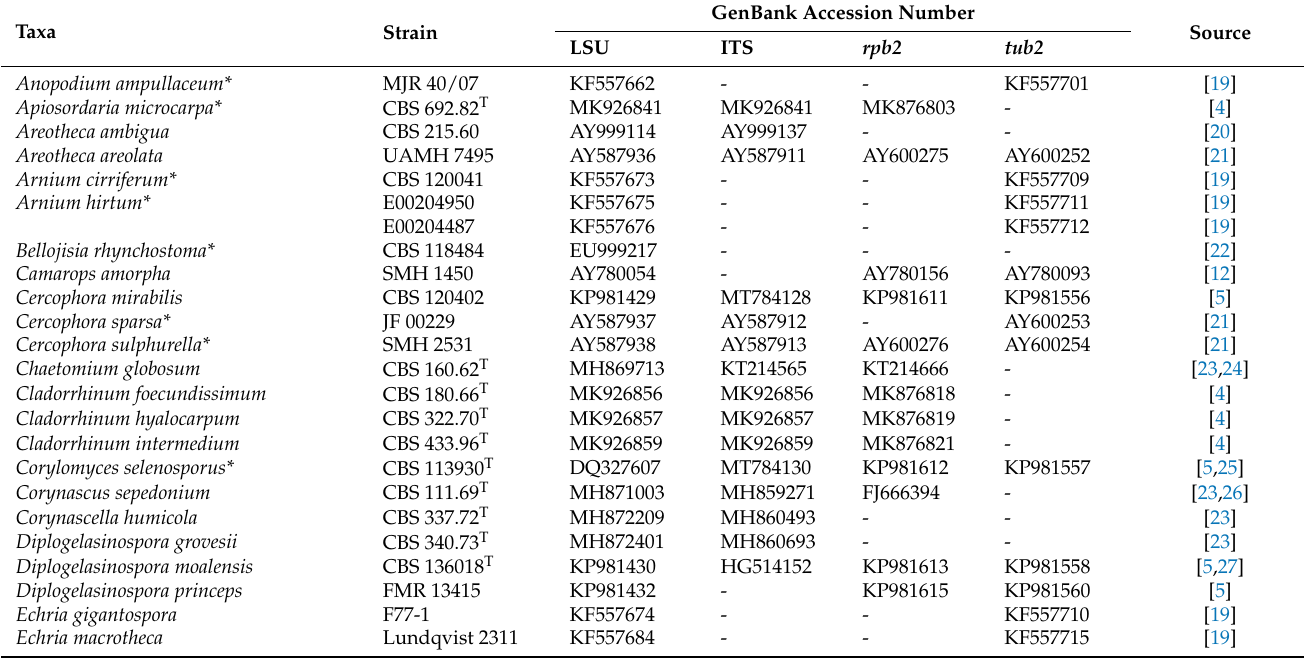
Table 1. Strains of the order Sordariales included in the phylogenetic study. GenBank accession numbers in bold correspond to the newly generated sequences. Taxonomic novelty is indicated in italic bold